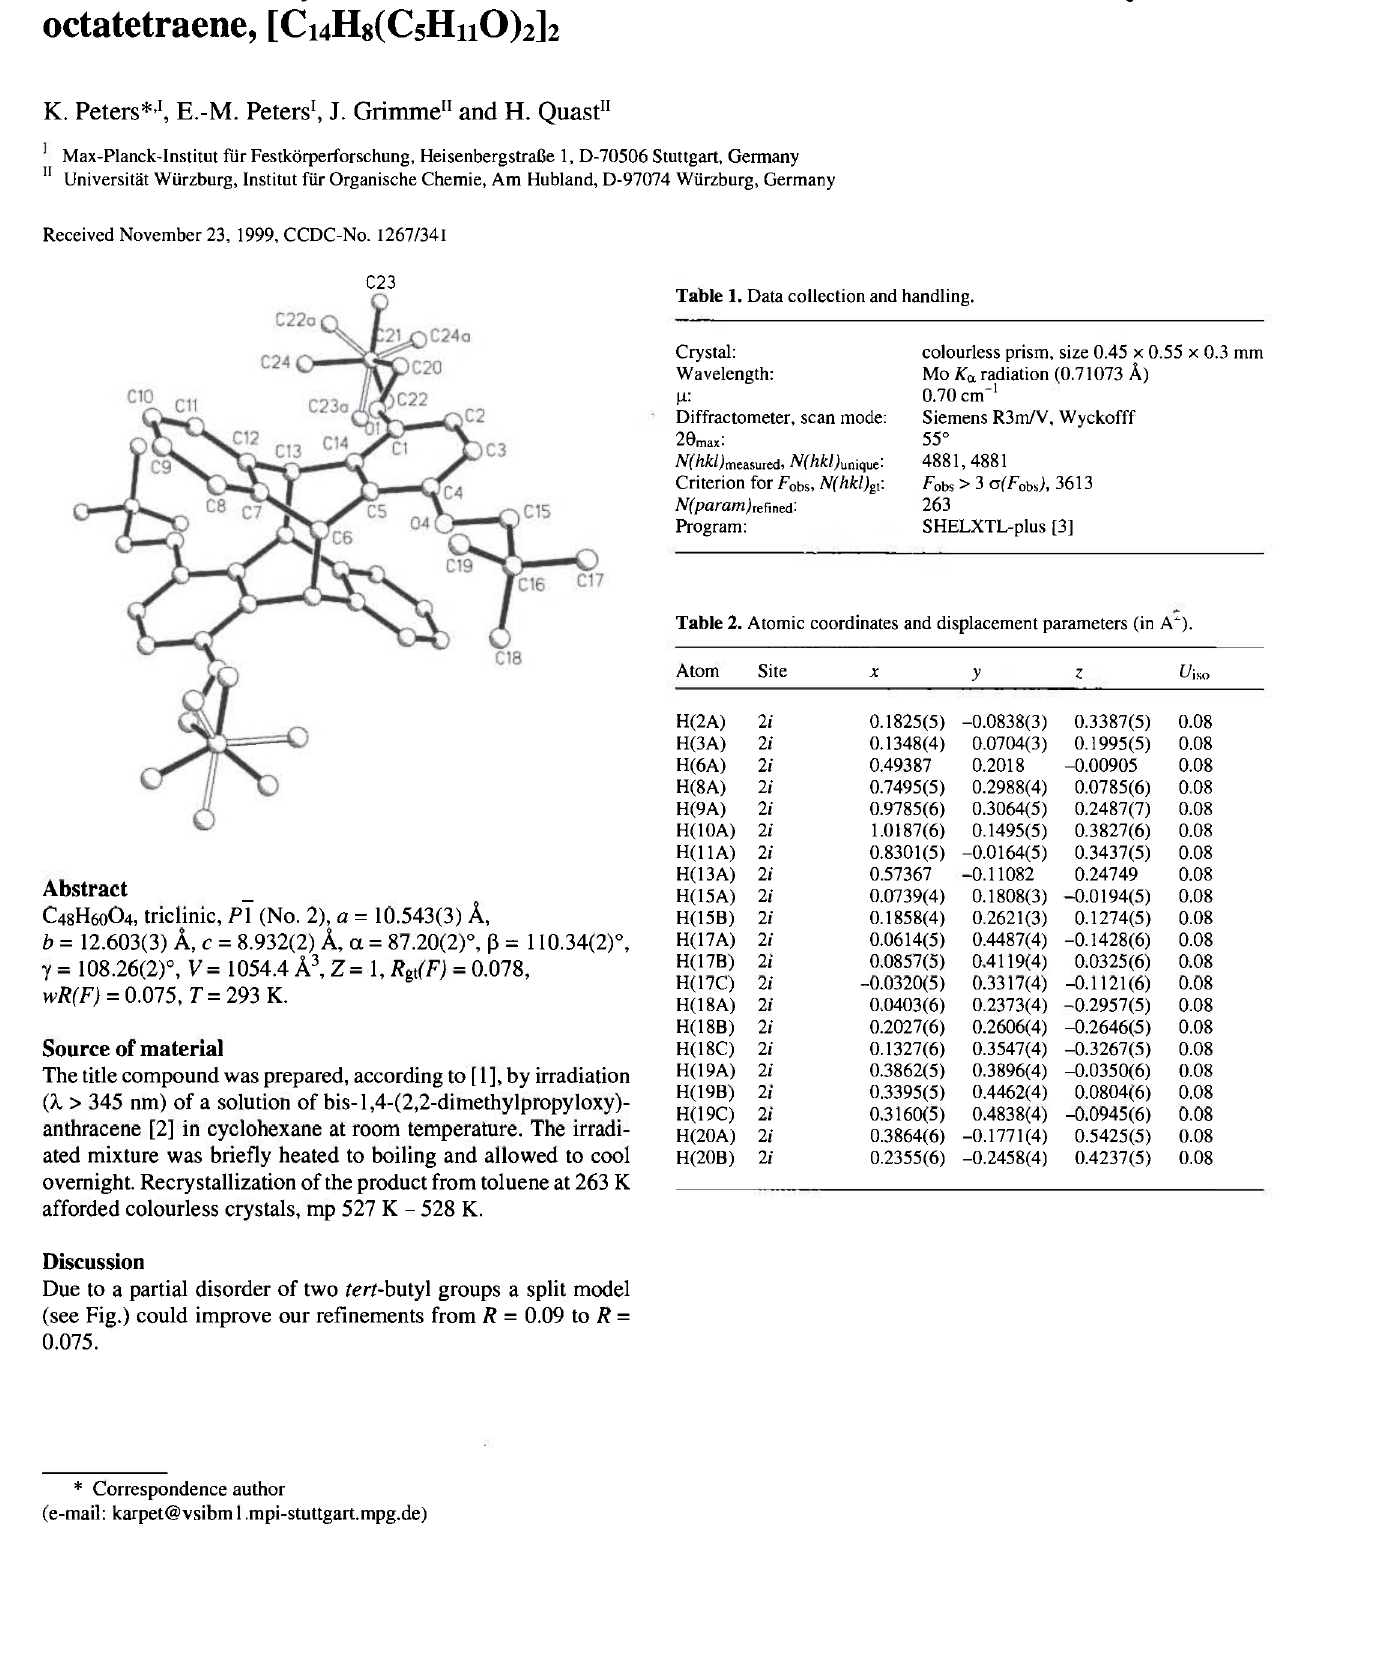
Table 1. Data collection and handling.